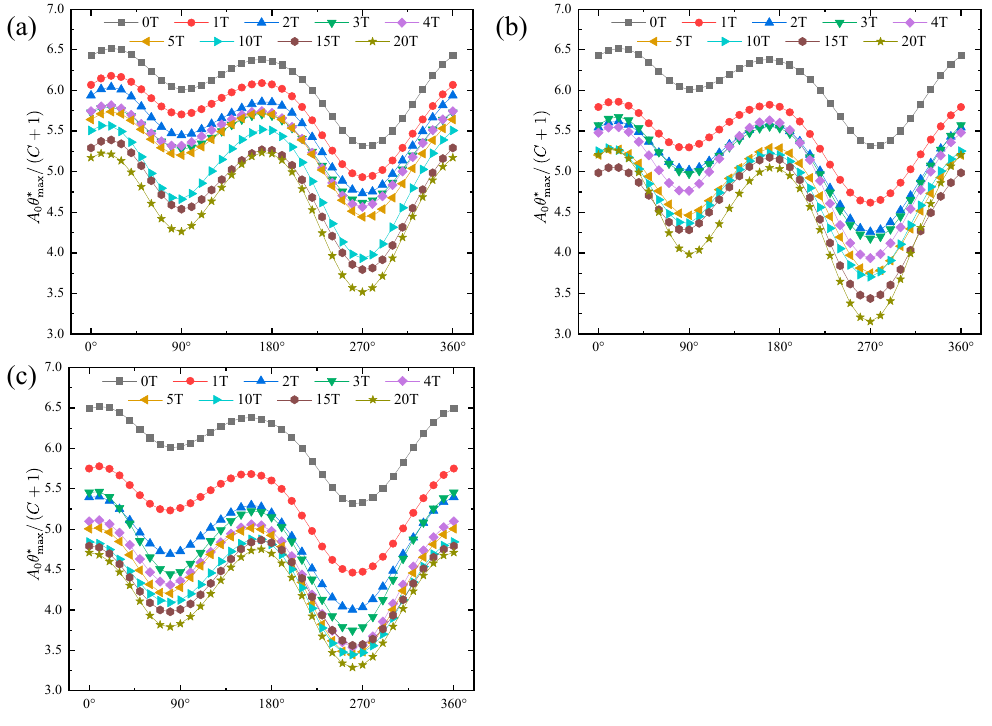
Figure 11. Direct coordinate system of the 3D roughness parameter, A 0 θ ∗ max / ( C + 1 ) , of the lower joint surface under different normal stresses: ( a ) 0.4 MPa, ( b ) 1.0 MPa, and ( c ) 2.5 MPa.